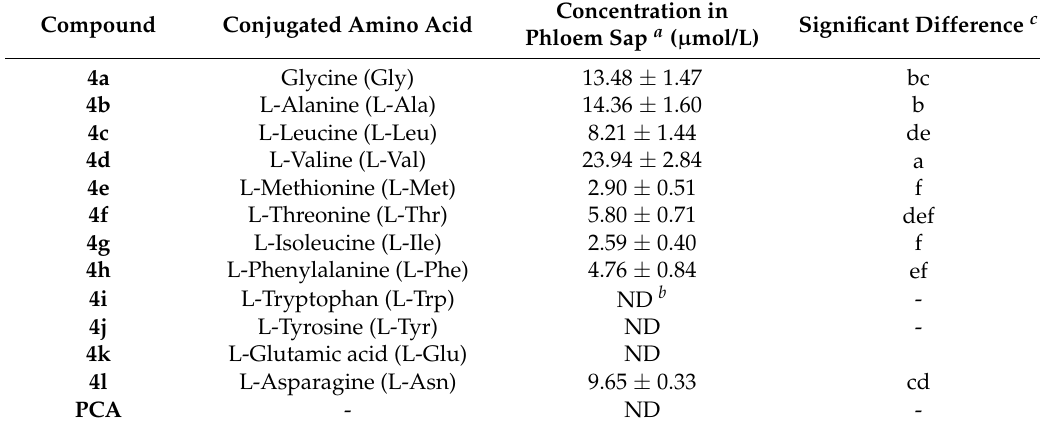
Table 3. Analysis of phloem sap.